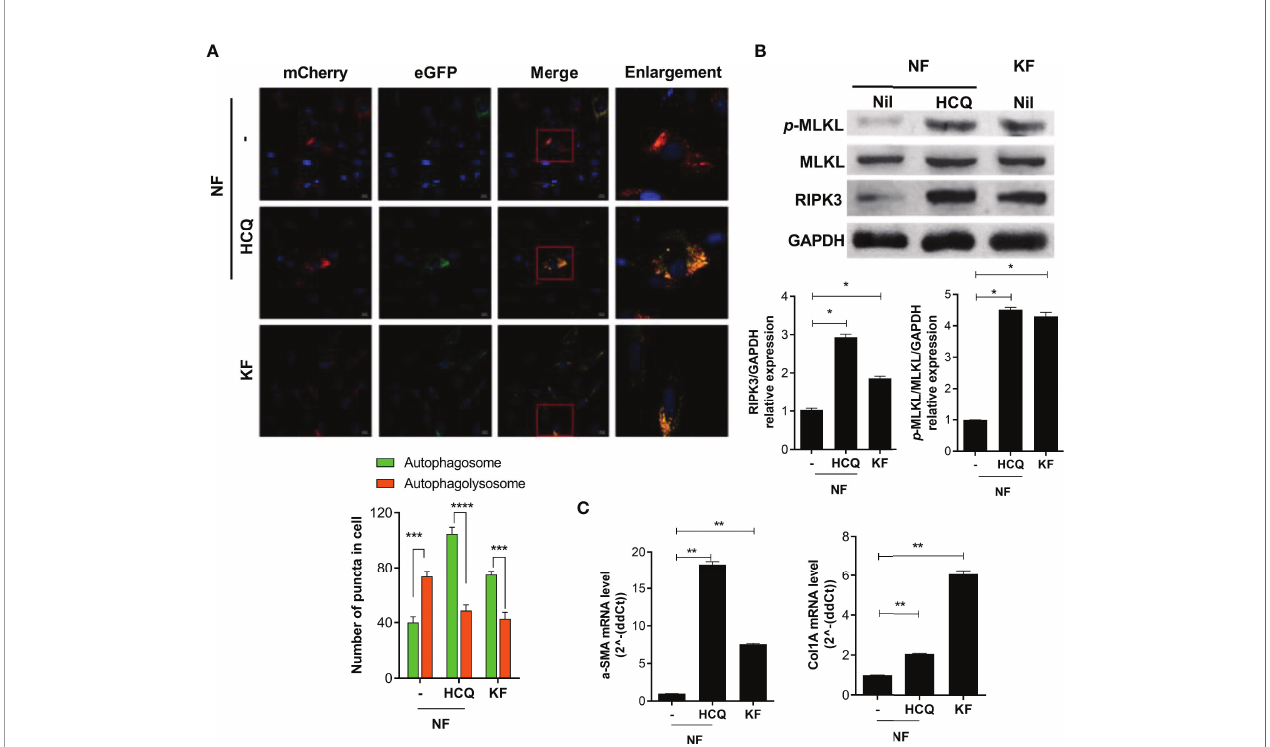
FIGURE 3 | Defective autophagy is associated with necroptosis and fi brosis. NF and KF were transfected with pBABE-puro mCherry-EGFP-LC3B, and NF were cultured with HCQ (20 m M) for 48 h. (A) Autophagosomes (bright yellow) and autophagolysosomes (bright red) were analyzed by confocal microscopy. (B) Protein levels of p -MLKL, MLKL, RIPK3 and GAPDH in HCQ-treated NF and KF were analyzed by Western blotting. (C) mRNA levels of a -SMA and Col1A were analyzed by real-time PCR. Bar graph shows data from one of three independent experiments; results are means ± SD of three independent experiments per group (* P <